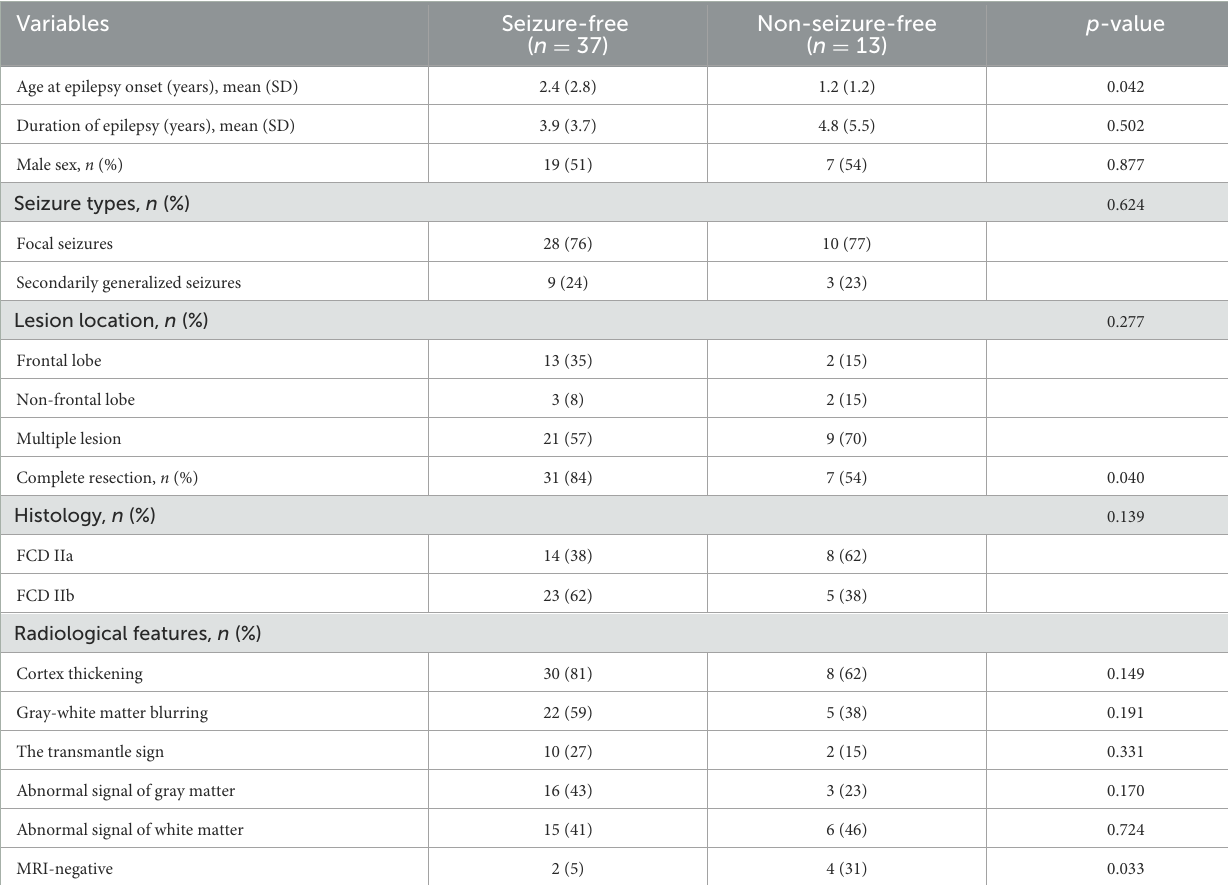
TABLE 1 Comparison of clinical characteristics and radiological features between the seizure-free and non-seizure-free groups.